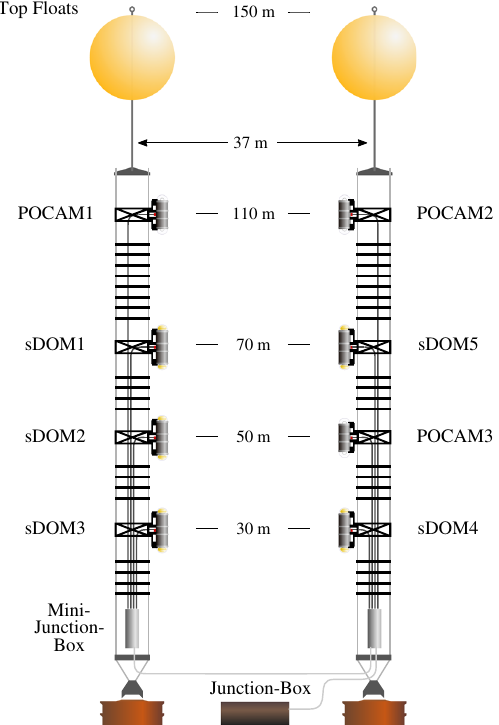
Fig. 3 Detailed technical sketch of the two STRAW mooring lines showing the position of all